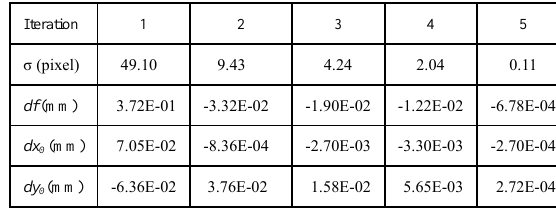
Table 2. The corrections of interior orientation parameters of Trail